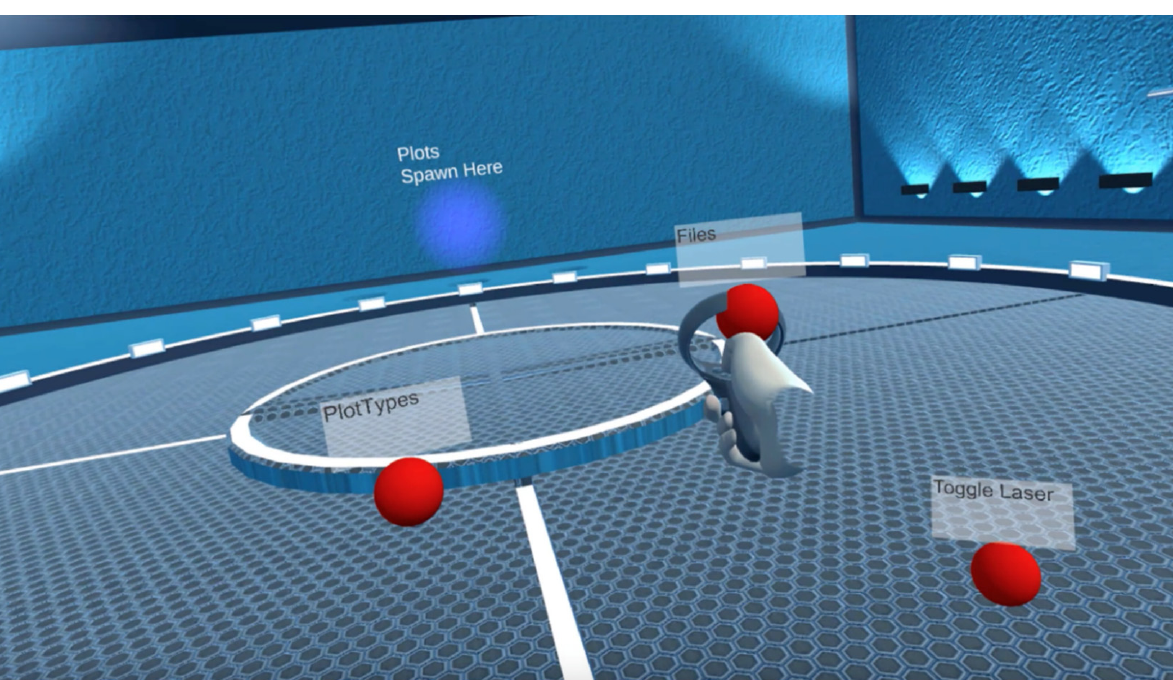
Figure 4. User swiping the right hand to select the “ Files ” object .